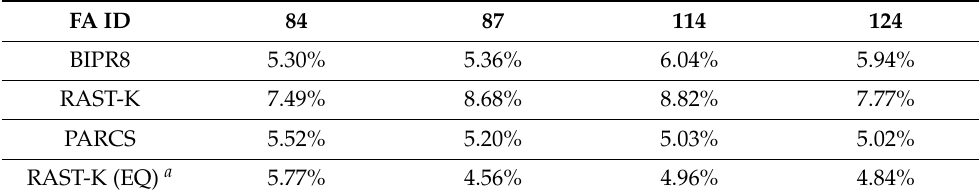
Figure 25. Axial power difference at 36.73 effective days. Table 7. Relative RMS difference of axial power